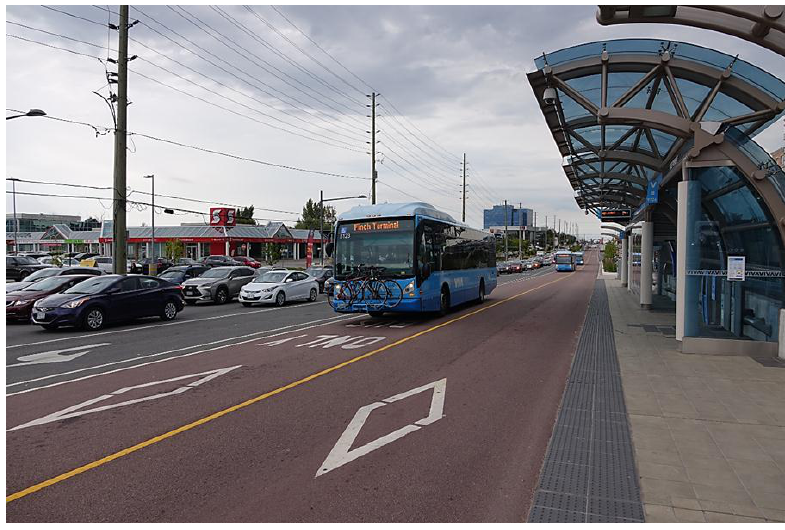
Figure 1. A section of coloured bus rapid transit (BRT) lane at York Region, ON, Canada.